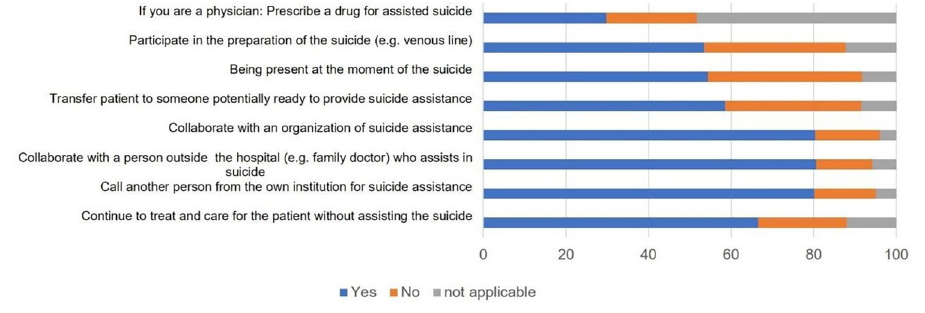
Fig 3. Readiness to participate in assisted